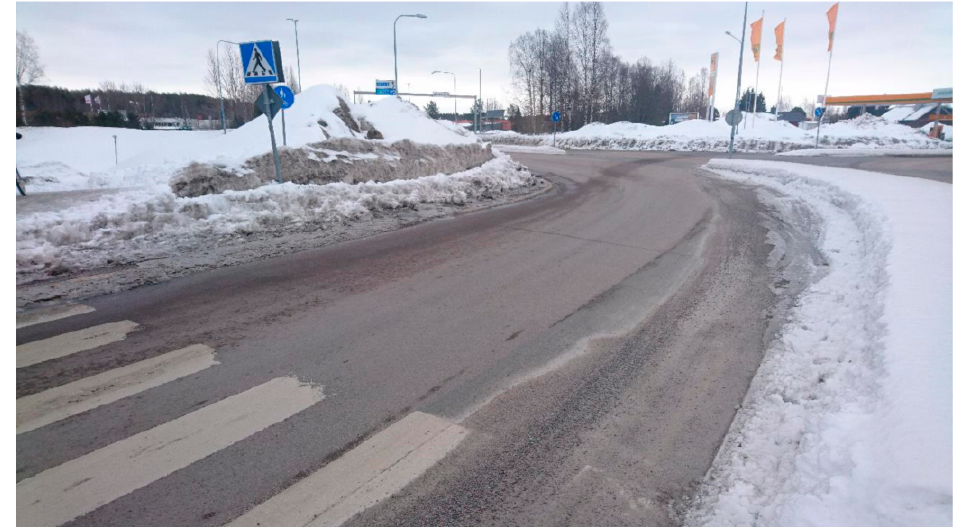
Figure 4. A participant’s photograph shows how walkways can ‘disappear’ in the winter